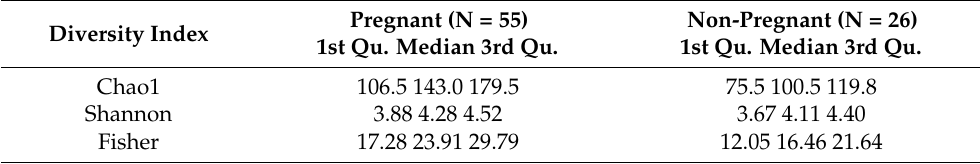
Table 2. First quartile, median, and third quartile of the alpha diversity in the two